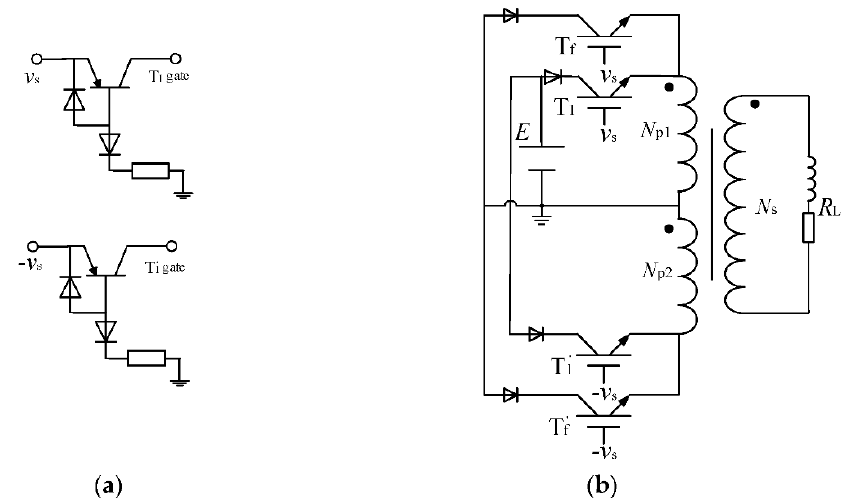
Figure 2. A single-stage linear converter topology with all-N transistor. ( a ) Control signal judgment circuit. ( b ) Main circuit topology.